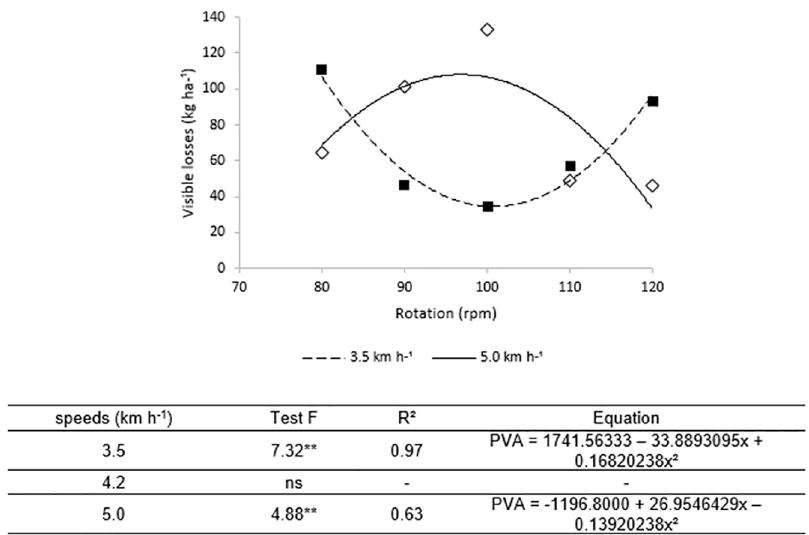
Fig 4. Estimated visible losses versus the rotation of the vibrating conveyor belt for the velocities 3.5 and 5 km h -1 . The equation of adjustment of each interaction is shown below Fig 4, when this was significative by the F test (p < 0.05). The speed 4.2 km h -1 did not obtain significant adjustment